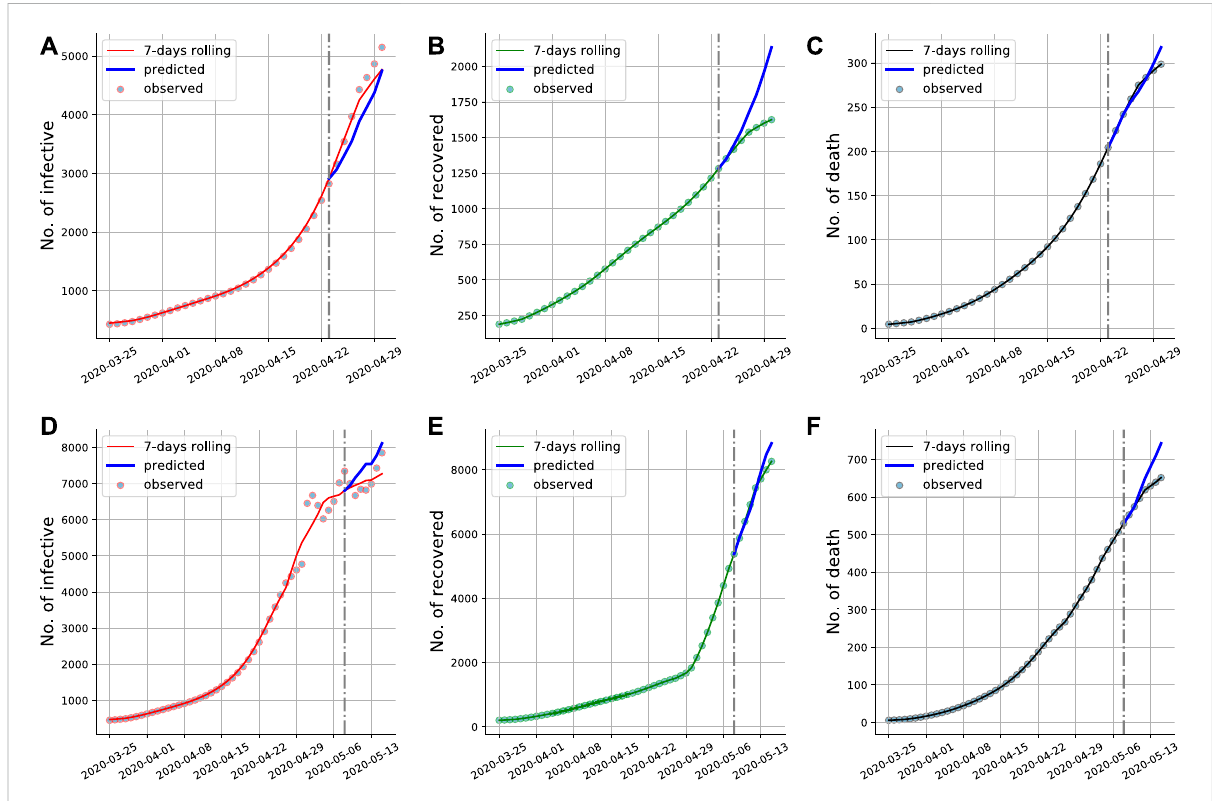
FIGURE 8 Euler-PINNs prediction for the early stage of COVID-19 in Minnesota. The gray vertical line divides the fi tting and prediction window. We have includedthenewavailabledataforthepredictionperiodthatwerenotusedinthe fi ttingtoshowthatthepredictionsarecorrect. (A) and (D) :Current infections. (B) and (E) : Cumulative recovery. (C) and (F) : Cumulative deaths.